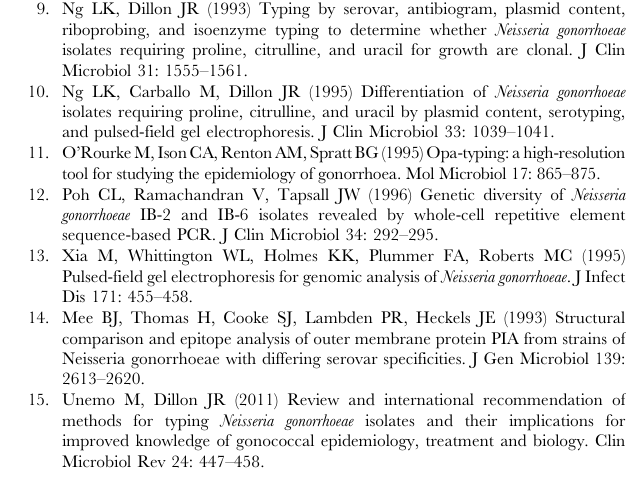
Table S1 Details of N. gonorrheae isolates used in this